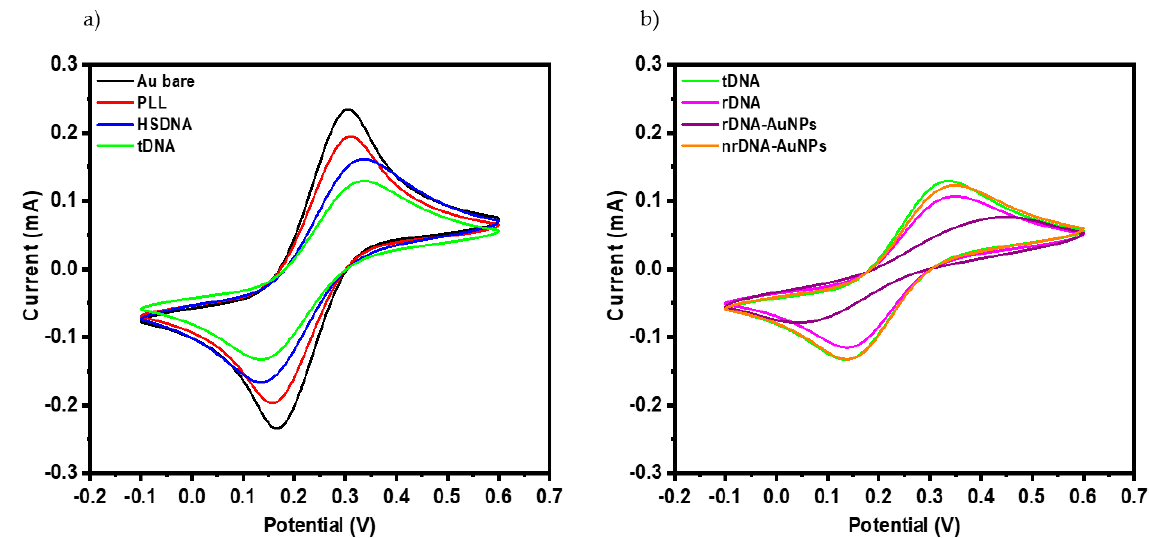
Figure 2. Cyclic voltammograms of gold substrates before and after coating with: monolayer of PLL- OEG 22 -Mal 4.6 and HS-DNA, tDNA, and then followed by rDNA, rDNA-AuNPs or nrDNA-AuNPs. ( a ) Stages of preparation the sensing layer, adsorption of PLL, immobilization of the HS-DNA probe and the hybridization with the tDNA, and ( b ) studying the hybridization process between t- DNA and rDNA, rDNA-AuNPs, and nrDNA-AuNPs. All measurements were performed in 100 mM K 2 SO 4 with 1 mM [Fe(CN) 6 ] 3 − /4 − vs Ag/AgCl as a reference electrode (scan rate 100 mV s − 1